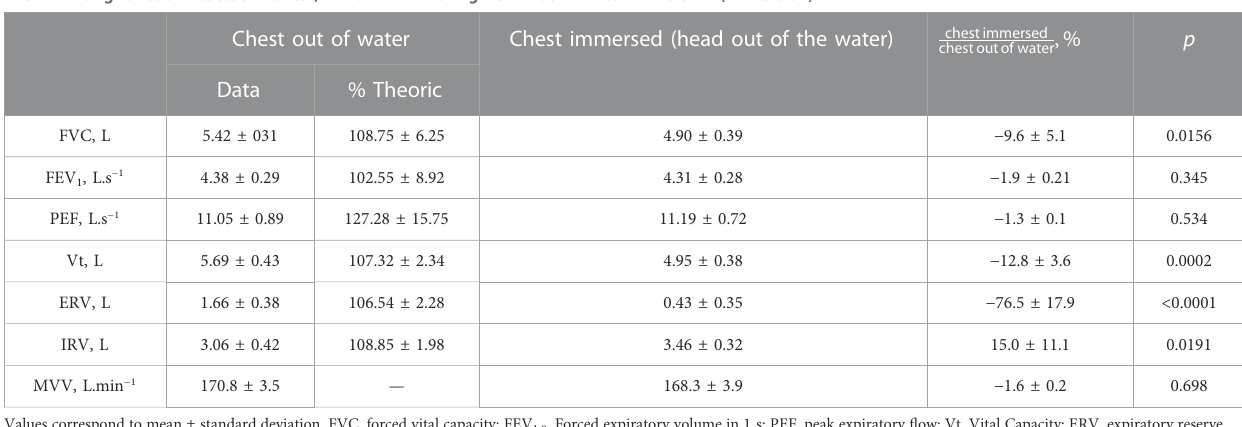
TABLE 1 Lung function assessed at rest, on land and during head-out-of-water immersion (Immersion). Chest out of water Chest immersed (head out of the water) chestimmersed